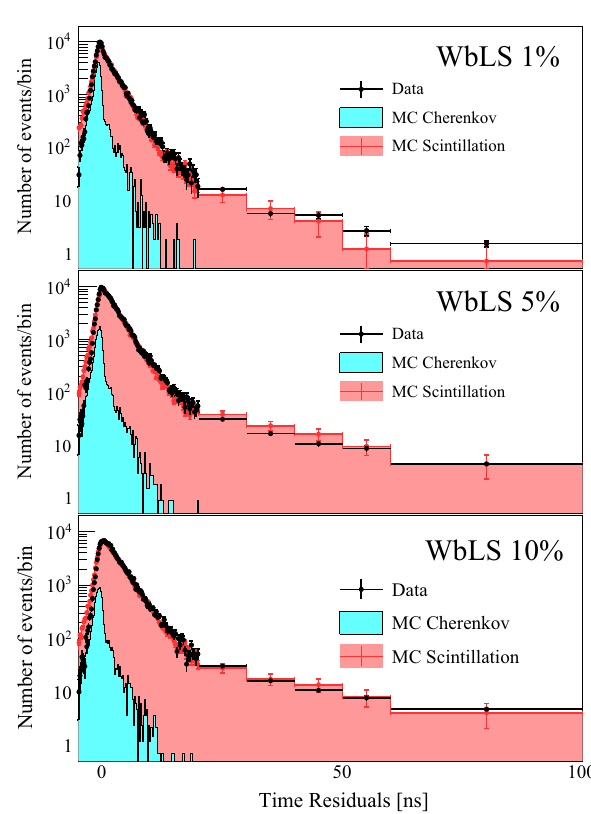
Fig. 4 Scintillation time profile as detected by the PMT array. Black dotsrepresentdatawithstatisticaluncertainties,andcoloredhistograms correspond to MC, which is divided into Cherenkov (blue) and scintil- lation components (red). MC includes only statistical uncertainties